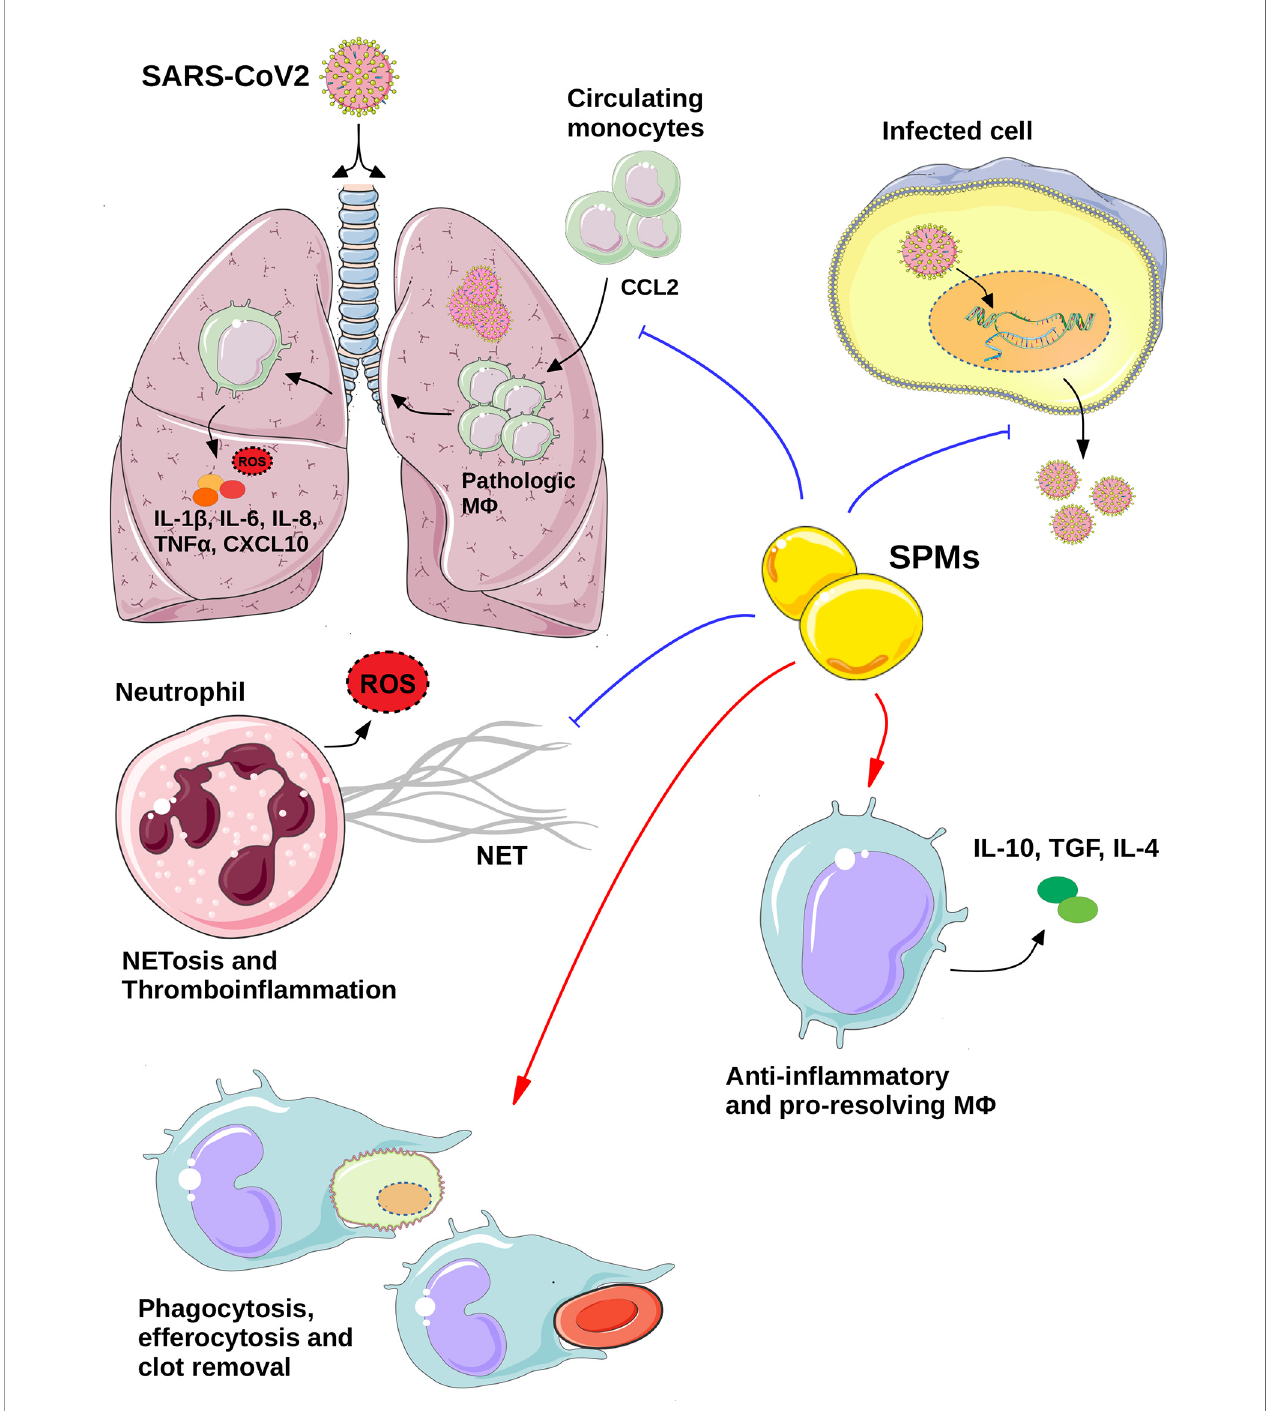
FIGURE 1 | The potential therapeutic role of SPMs in COVID-19. Specialized pro-resolving regulators (SPMs) mediate their anti-viral effects via directly inhibiting the viral replication and thus export of viral particles from infected cells and/or via regulating the functions of key immune cell types. SPMs act on neutrophils inhibiting NETosis and thrombroin fl ammation, while they regulate the macrophages responses on various levels including: inhibition of monocytes in fi ltration to the in fl ammed lungs, as well as, stimulation of homeostatic processes, via induction of efferocytosis, phagocytosis of debris and blood clots and anti-in fl ammatory and pro-resolving macrophages polarization. All these effects may eventually lead to the resolution of SARS-CoV2-induced in fl ammation and thus, potential management of COVID-19 pathologies. Blue lines indicate inhibition, whereas red arrows indicate induction. (Templates from Servier Medical ART, https://smart.servier.com/, were used to create this image) M F , Macrophage; ROS, Reactive oxygen